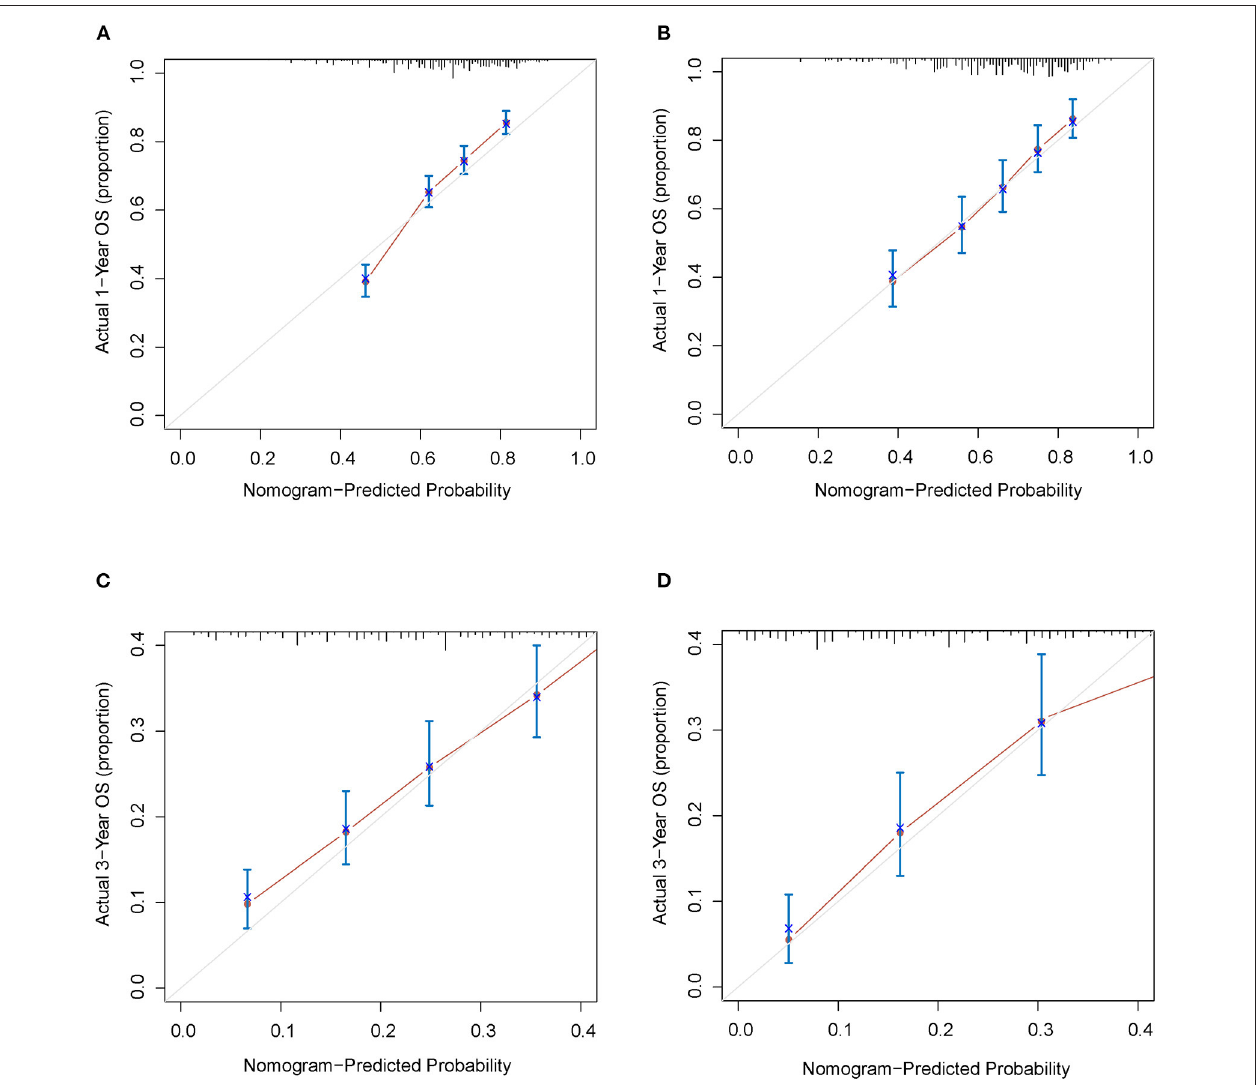
FIGURE 4 | Calibration plots for 1- and 3-years OS of the nomogram. (A) Calibration plot of 1-year OS in the training cohort; (B) Calibration plot of 1-year OS in the validation cohort; (C) Calibration plot of 3-year OS in the training cohort; (D) Calibration plot of 3-year OS in the validation cohort. OS, overall